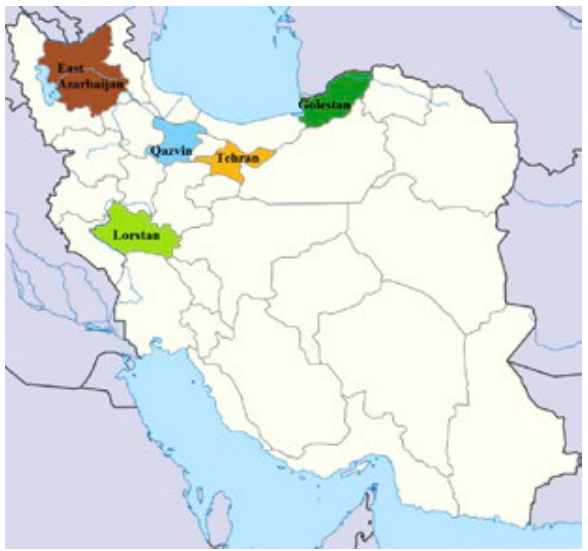
Figure 1. Map of Iran provinces showing regions from which Fusarium isolates were obtained from wheat